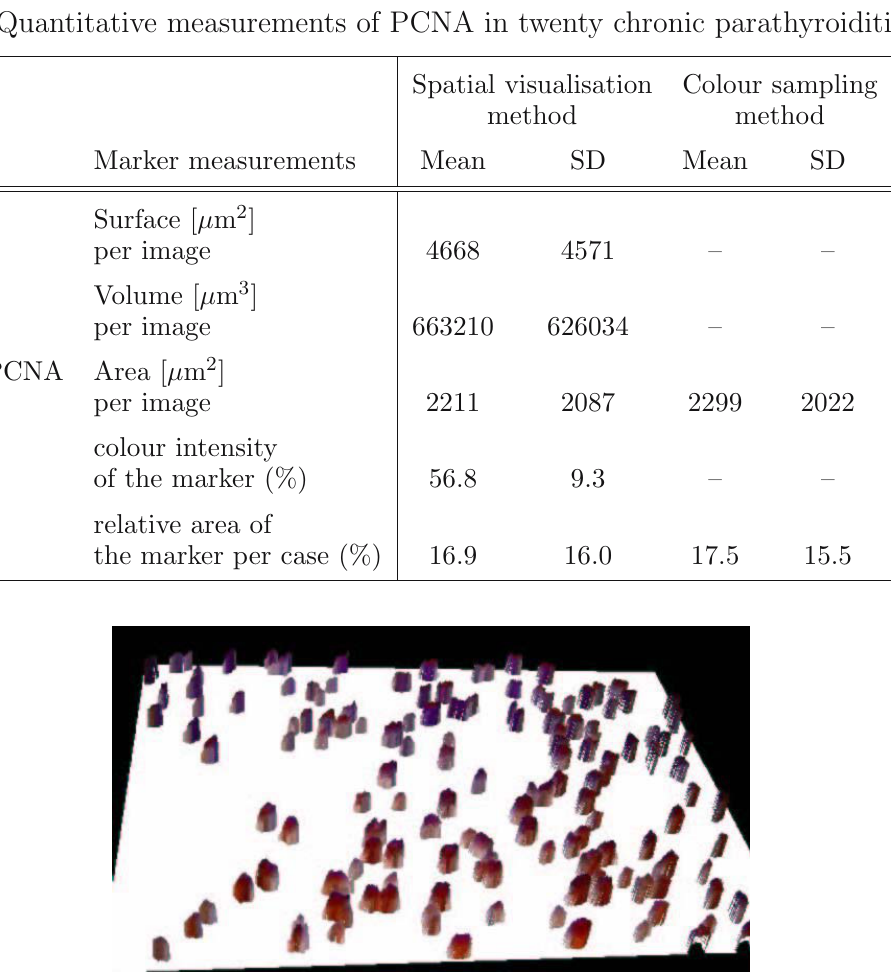
Fig. 2 Spatial visualisation of PCNA presented in Figure